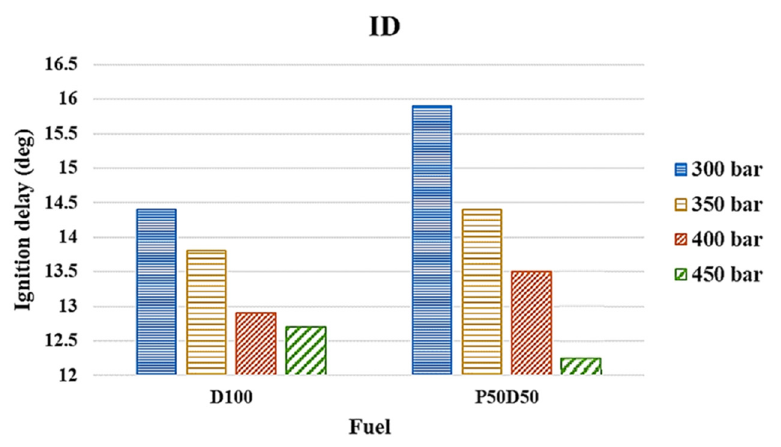
Figure 3. ID under various injection pressures.